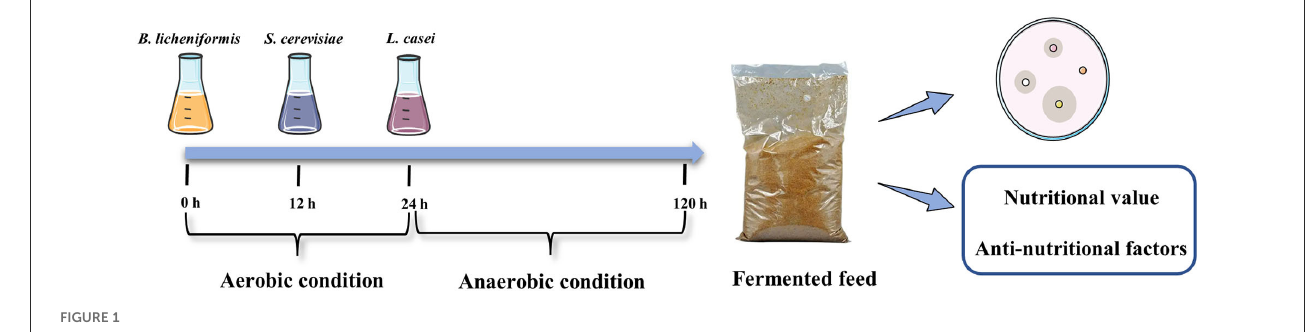
FIGURE1 Production of fermented feed.